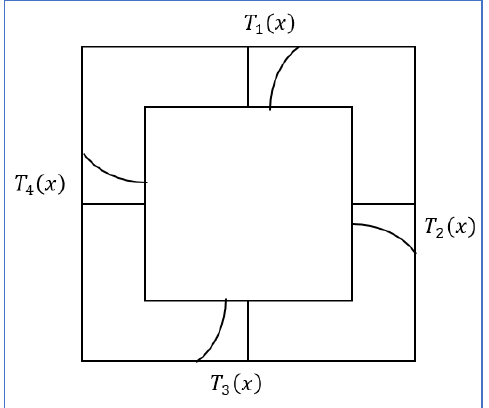
, , , and in the diagram 𝑇𝑇 1 ( 𝑥𝑥 ) 𝑇𝑇 2 ( 𝑥𝑥 ) 𝑇𝑇 3 ( 𝑥𝑥 ) 𝑇𝑇 4 ( 𝑥𝑥 )